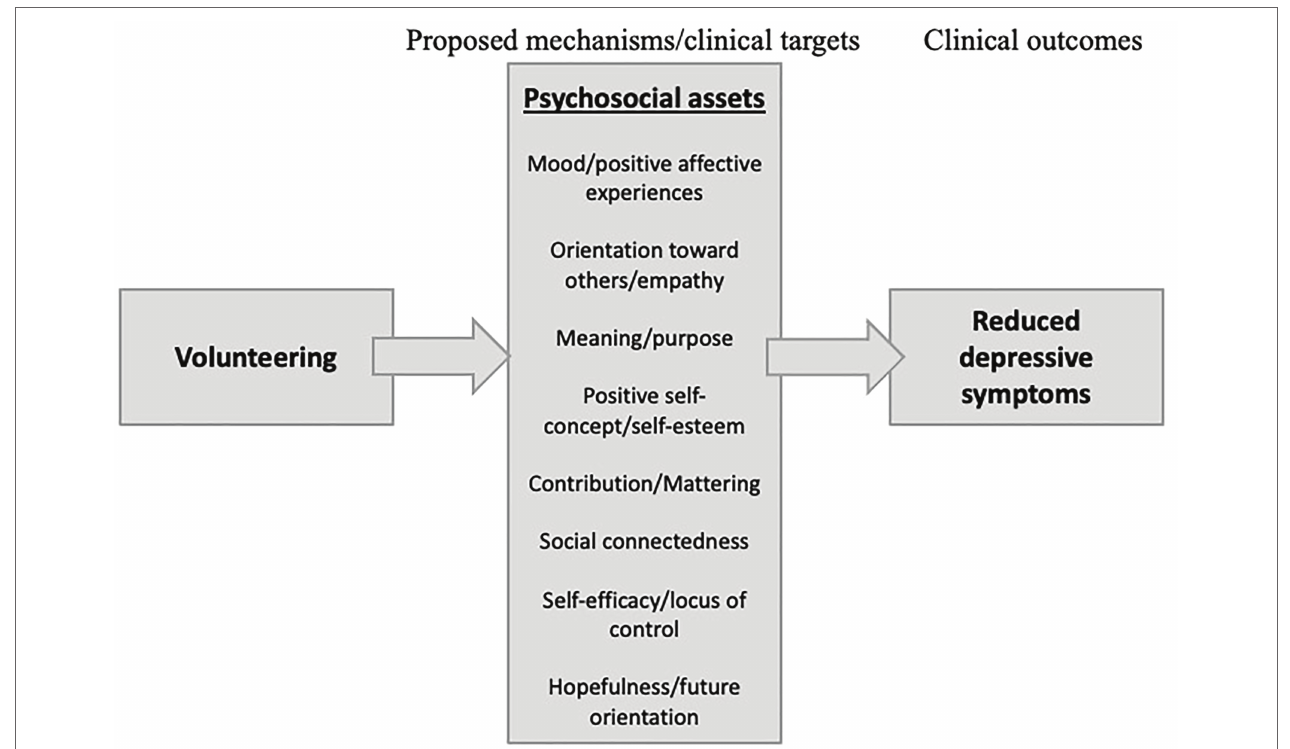
FIGURE 1 | Prosposed mechanisms/clinical targets whereby volunteering affects depressive